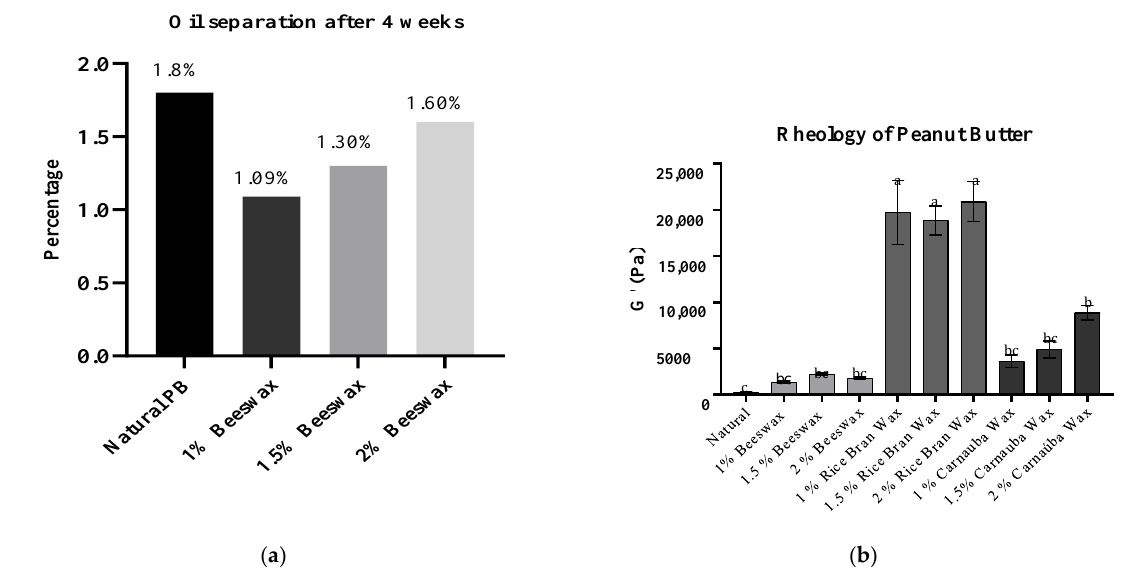
Figure 2. Percentages of used waxes in peanut butter, oil separation, and rheology. (a) represents the percentage of added waxes and oil separation of the samples in preliminary test; (b) represents the viscoelasticity (G’) of all samples in preliminary test. a-c : same letter on the rheology figure means no significant ( p>0.05 ) differences between the values.